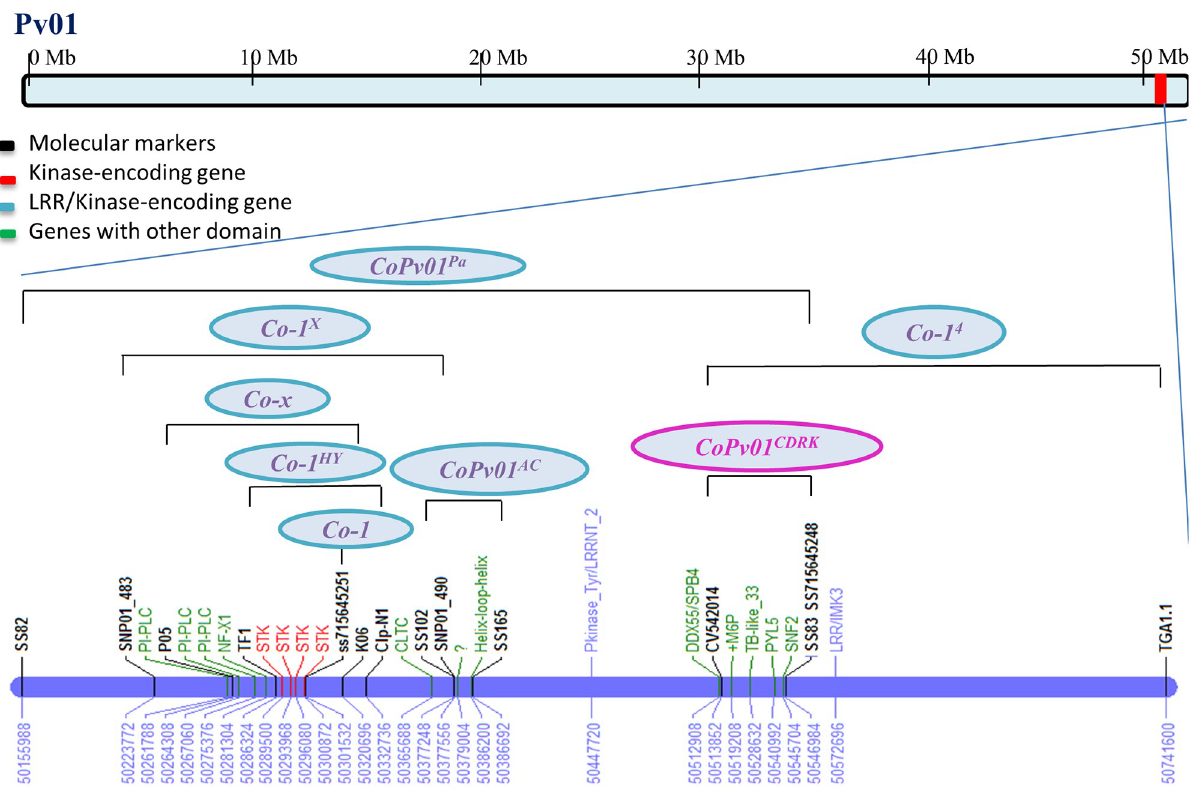
Fig 3. Anthracnose cluster 1.1 on Pv01 with specific candidate genes within and close to the genomic region where these resistance genes were mapped. Molecular markers linked to the resistance genes are displayed in black color. In red candidate genes that encode kinases, in blue candidate genes encoding NB-LRR and in green candidate genes with other domains. The resistance gene in CDRK cultivar was fine mapped in a region having five candidate genes and close to LRR. Co-1 HY , Co-x and Co-1 X harbor the same kinases. CoPv01 AC , Co-1 4 and CoPv01 PA are the resistance genes of the Amendoim Cavalo, AND 277 and Paloma cultivars,